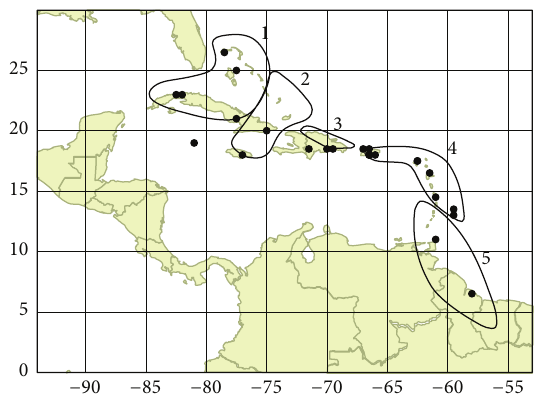
Figure 1: Five rainfall zones over the Caribbean and neighbouring regions. Observational weather stations used in this study are also